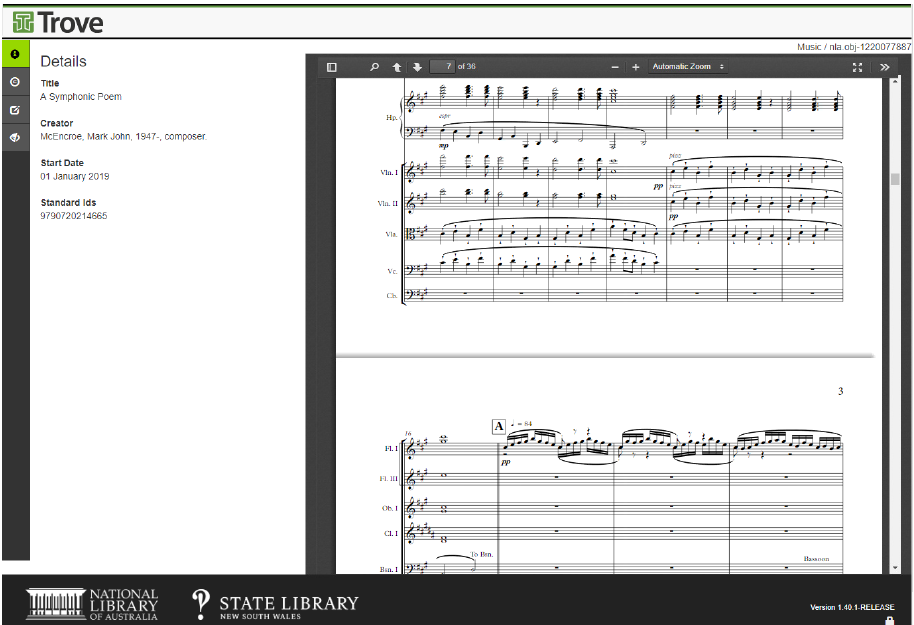
Figure 5. Example of a restricted access item in NED, using the Citrix viewer.